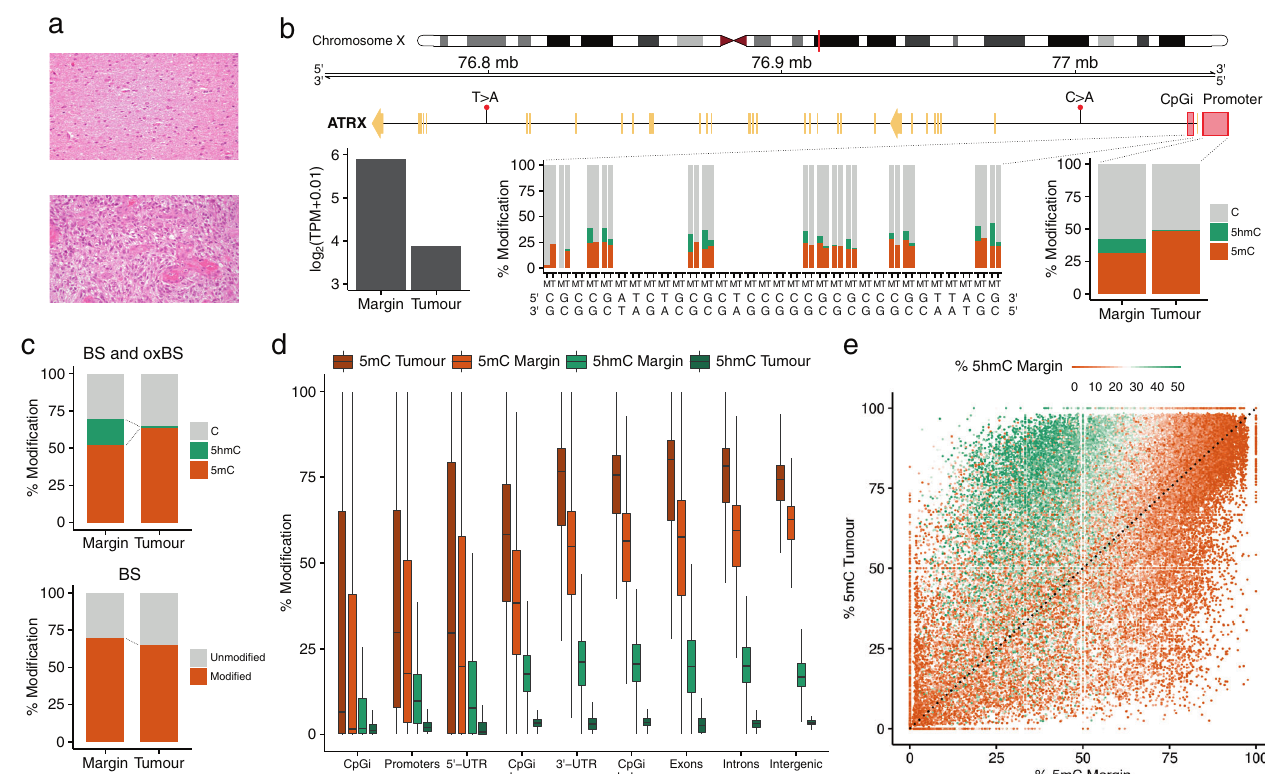
Fig. 1 Cytosine modi fi cation landscape of all CpG sites ( n = 2.7 × 10 7 ) in a glioblastoma patient. a Hematoxylin and eosin (H&E) staining of the margin ( top ) and tumour ( bottom ) samples (see Methods). b Base resolution outlook of 5mC and 5hmC levels, nucleotide alterations and changes in transcript levels between margin (M) and tumour (T) in the ATRX gene. The close view highlights 32 bp of the CpG island (chrX:77041003-77041725) located in the 5 ′ -UTR region ( middle ) and average levels of modi fi cation across the 1 kb promoter (chrX:77041719- 77042719) ( right ). Transcript levels ( left ) are displayed in transcripts per million (TPM). c Combination of BS and oxBS-seq reveals a severe decrease of 5hmC in tumour accompanied by an increase of 5mC, however BS-seq only cannot distinguish between 5mC and 5hmC, and would suggest tumour hypomethylation. Distribution of 5mC and 5hmC in the margin and tumour samples d across genomic regions and e in a sample of 10 5 CpG sites colour-coded according to the level of 5hmC in the